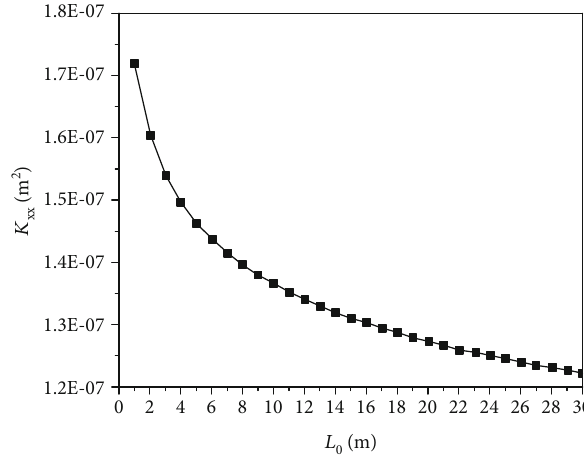
Figure 13: The relationship between L β = 0 : 01 , θ = π /4 , and α = π /2 ).